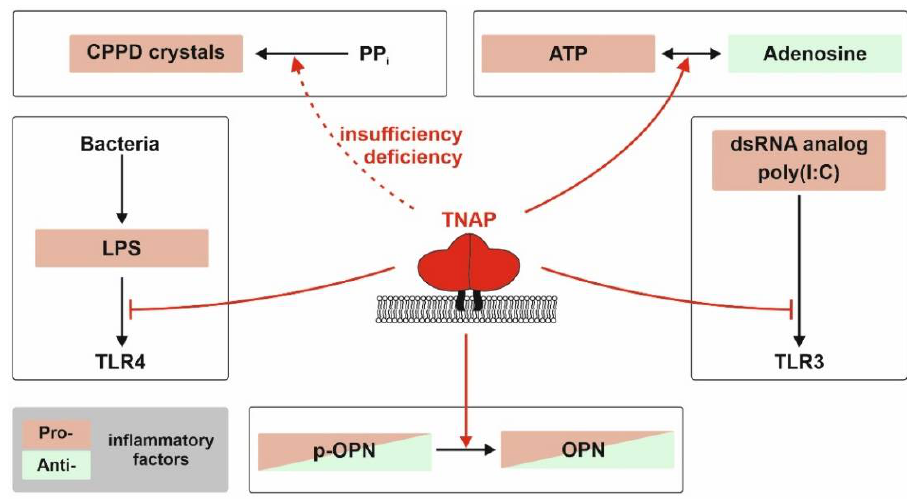
Figure 2. TNAP’s influence on the regulation of inflammation processes. ATP: adenosine triphos- phate, CPPD: calcium pyrophosphate dehydrate, dsRNA: double-stranded ribonucleic acid, LPS: lipopolysaccharide, OPN: osteopontin, poly(I:C): poly-inosine:cytosine, p-OPN: phosphorylated osteopontin, PP i : inorganic pyrophosphate, TLR3: toll-like receptor 3, TLR4: toll-like receptor 4, TNAP: tissue-nonspecific alkaline phosphatase. Note: All mechanisms depicted are solid in terms of data, except the role of p-OPN vs. OPN on anti-/pro-inflammatory-effects. Green: anti-inflammatory effects, red: pro-inflammatory effects .